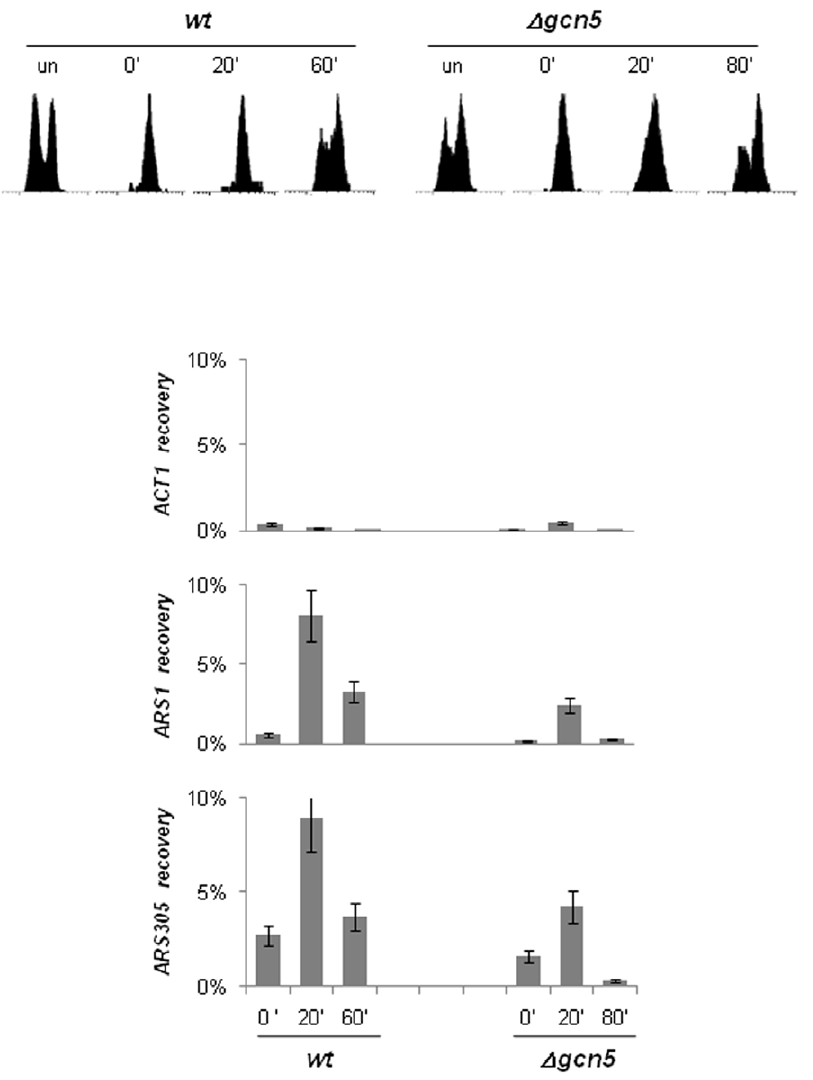
Figure 6. Reduced association of MCM proteins to ARS1 and ARS305 . Wild type (BY4742) and D gcn5 cells were arrested in Mitosis by12 m g/ml Nocodazole for 3.5 hours and released in YPD. Wild type cells were harvested at 0, 20 and 60 min past Nocodazole release. D gcn5 cells were harvested at 0, 20 and 60 min past Nocodazole release. Progression through the cell cycle as monitored by Propidium Iodide staining/FACS is shown on the top. Crosslinked chromatin was isolated and immunoprecipitated with anti-MCM2 and anti-MCM5 antibodies. The ACS fragments of ARS1 and ARS305 and a fragment from ACT1 were amplified by PCR (triplicate) and quantified. The per cent of signal from each fragment in the anti-MYC immunoprecipitate versus Load was calculated and plotted. A typical outcome of one of two independent experiments is shown.